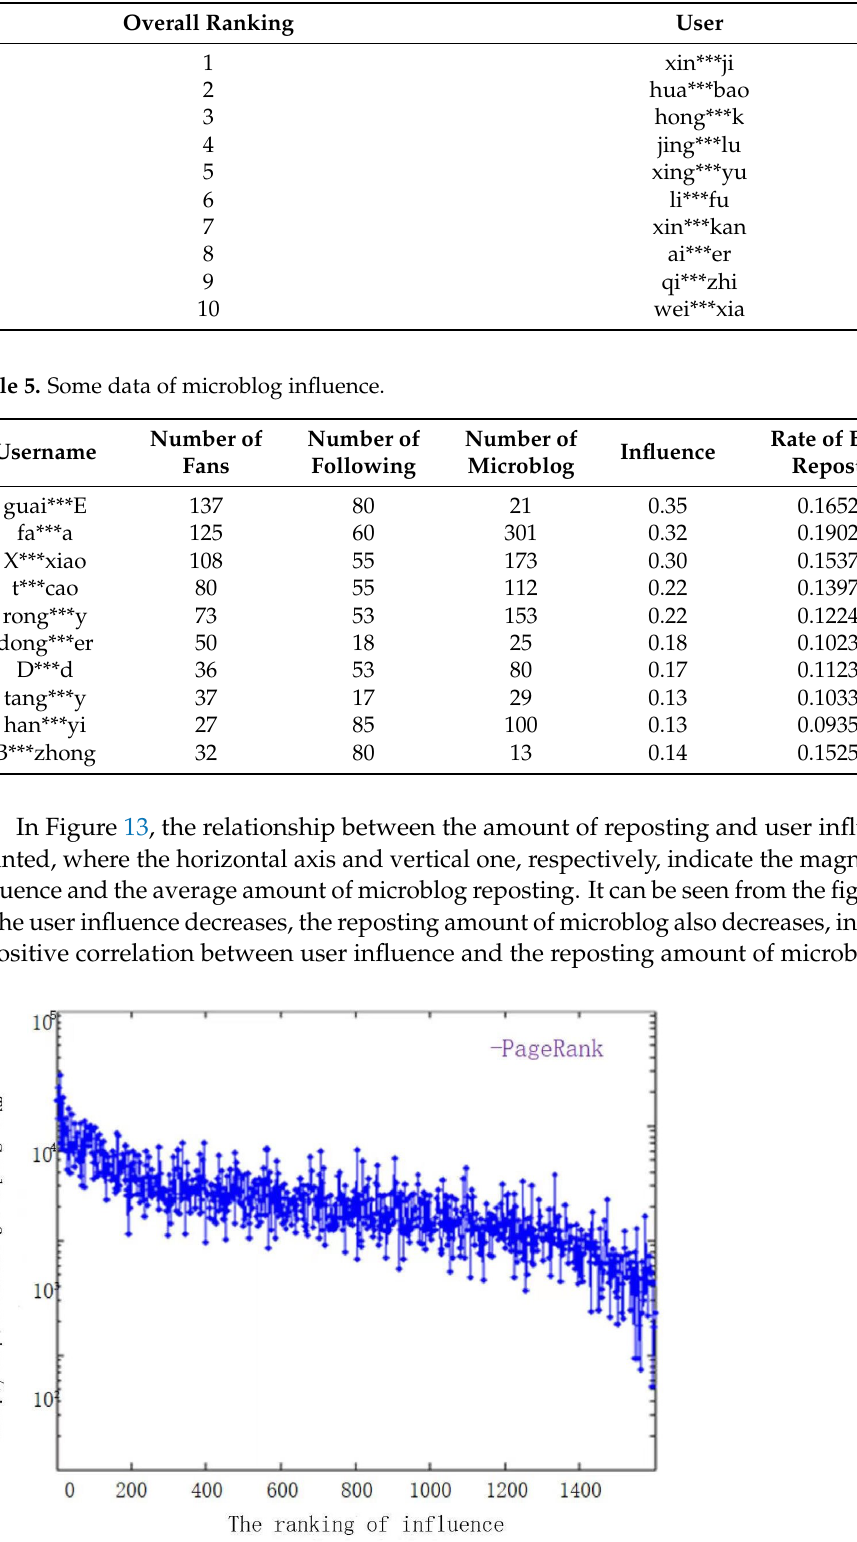
Table 4. The ranking of user influence.